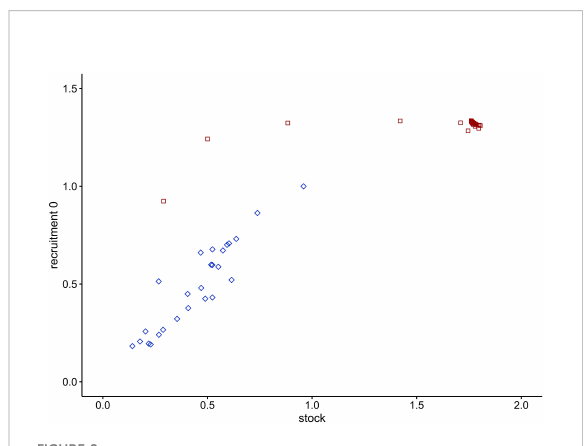
FIGURE 8 Stock-recruitment relationship of cod in the WBS ecosystem. Blue squares depict the trend from 1994 to 2019 after fi tting of the model; red squares illustrate the time series from 2020 to 2100, with predictions obtained under the EBFM